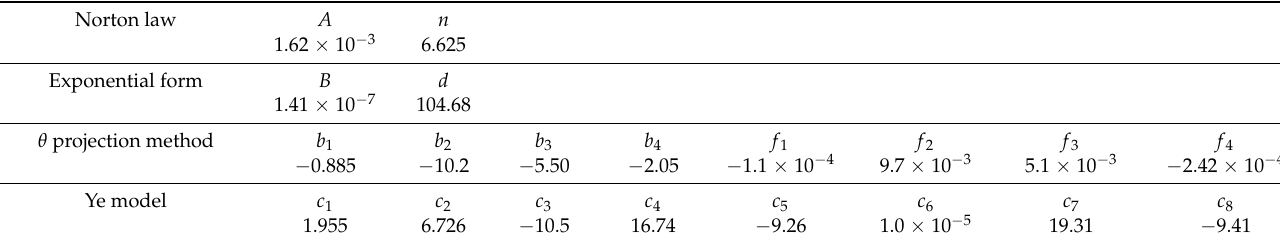
Table 2. Parameters of constitutive models.